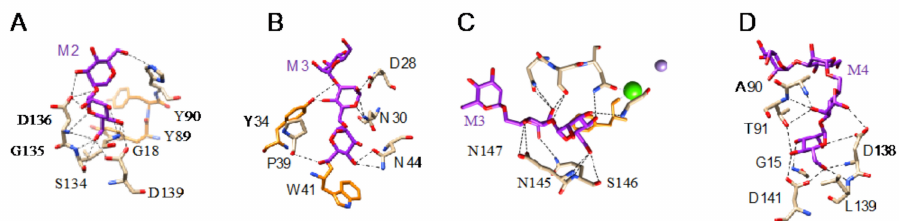
Figure 4. ( A ). Network of hydrogen bonds (black dashed lines) anchoring Man α 1,2Man (M2) to Heltuba from Helianthus tuberosus (PDB code 1C3N). Aromatic residues Y89 and Y90 participating in stacking interactions with the pyranose rings of mannobiose are colored orange. ( B ). Network of hydrogen bonds (black dashed lines) anchoring Man α 1,6Man α 1,3Man (M3) to GNA from Galanthus nivalis (PDB code 1JPC). Aromatic residues Y89 and Y90 participating in stacking interactions with the pyranose rings of mannobiose are colored orange. ( C ). Network of hydrogen bonds (black dashed lines) anchoring Man α 1,3Man α 1,6Man (M3) to PAL from Pterocarpus angolensis (PDB code 1Q8V). Aromatic residues Y89 and Y90 participating in stacking interactions with the pyranose rings of mannobiose are colored orange. ( D ). Network of hydrogen bonds (black dashed lines) anchoring mannotetraose (M4) to artocarpin from Artocarpus integer (PDB code 1VBP).